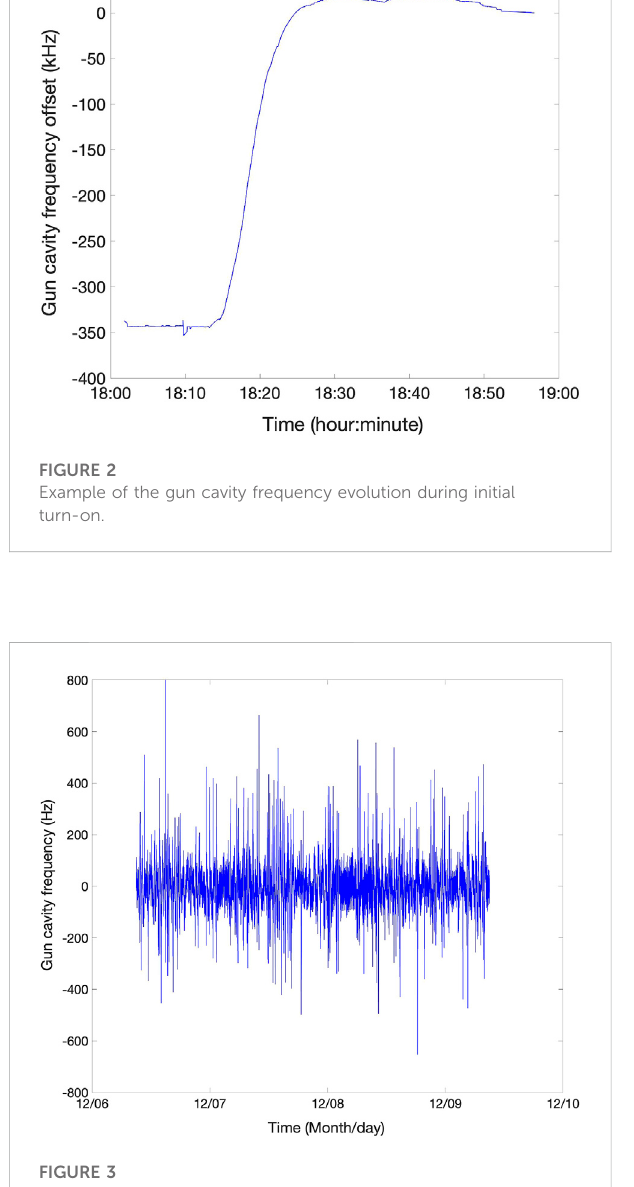
FIGURE 3 Example of the gun frequency regulation over a several-day period.